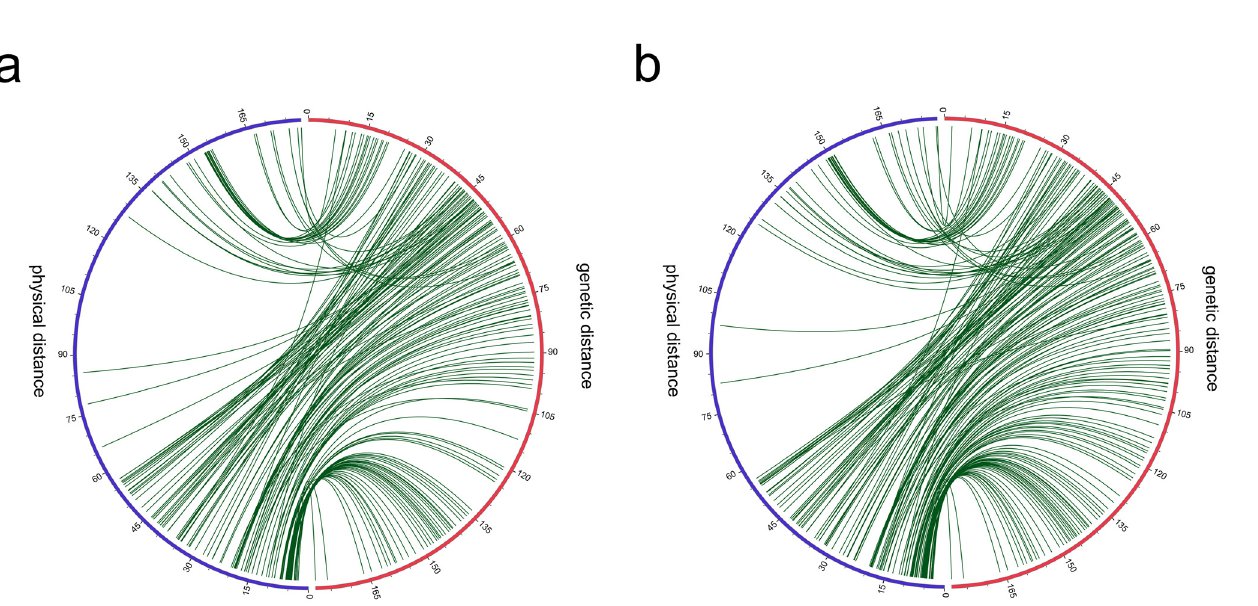
PLOS ONE | DOI:10.1371/journal.pone.0135430 August 11,